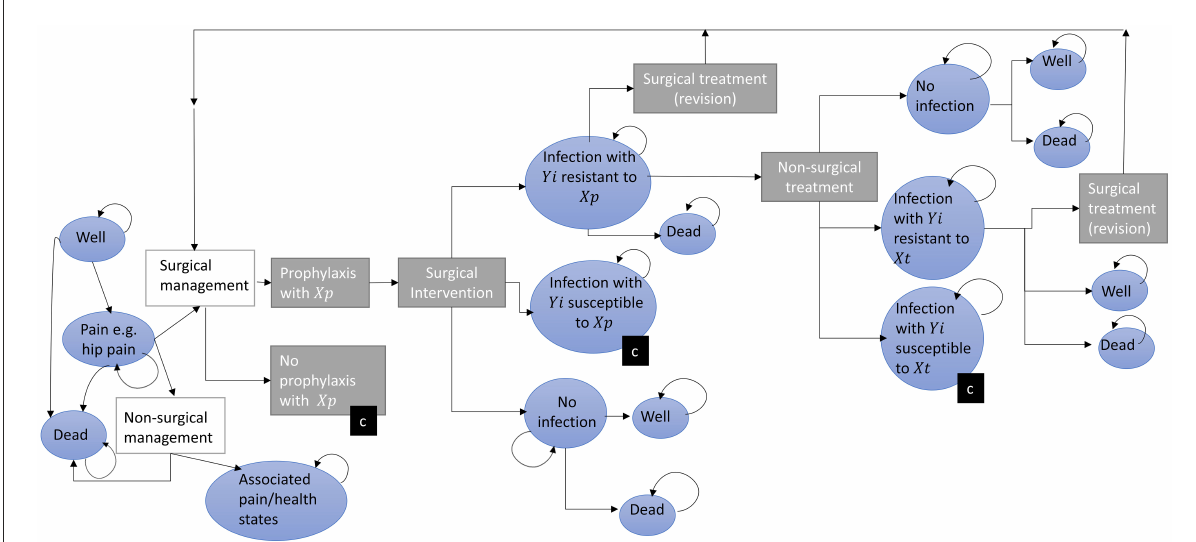
FIGURE2 A conceptual model for estimating the impact of antimicrobial resistance on surgery patients. The progress of patients through a surgical management pathway with the potential for infection is depicted following from left to right. Patients initially start (far left) in one of three health states (blue circles) and progress through treatment decisions (rectangles). Circles represent health states, rectangles represent pathway treatment decisions, (c) represents a collapsed branch that mirrors that of another branch within that level (for example the pathway following “No Prophylaxis” includes the same transitions and states as “Prophylaxis.” Yi represents microbes where i = 1,…,m different microbes of clinical importance; Xp,t represents antibiotics given for prophylaxis ( p = 1,…,n ) at time t , Tx represents antibiotics given for treatment of SSI ( t = 1,….,q ). It may be that p = t . The length of time patients spends in each state (indicated by a curved returning arrow) is